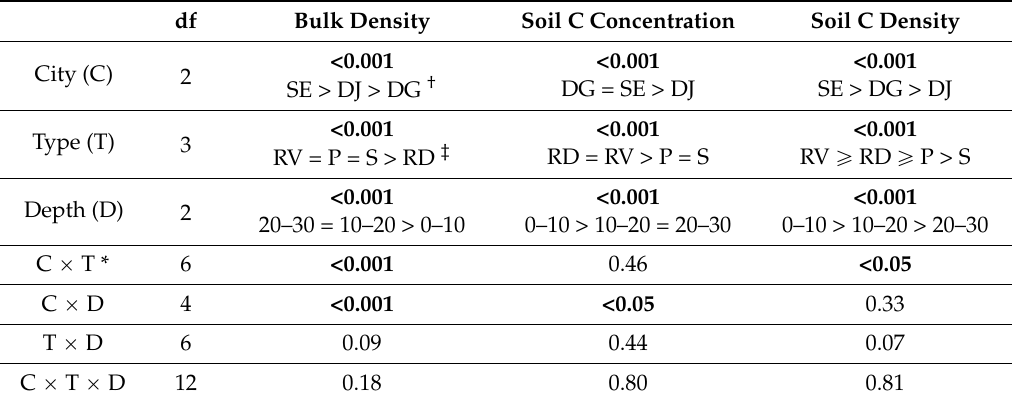
Figure 2. Soil C stock at 30-cm depths of urban green spaces in Seoul, Daegu, and Daejeon (South Korea).